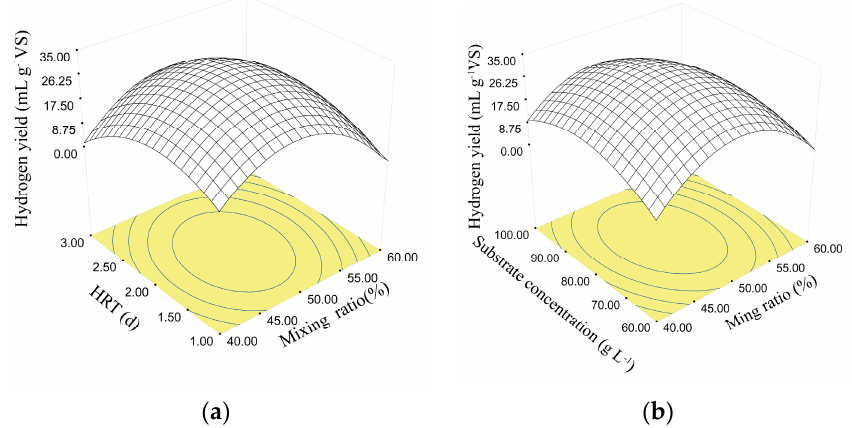
Figure 2. Three-dimensional (3D) response surface and two-dimensional (2D) contour plots for hydrogen yield. ( a ) Mixing ratio and hydraulic retention time (HRT), and ( b ) substrate concentration and mixing ratio.